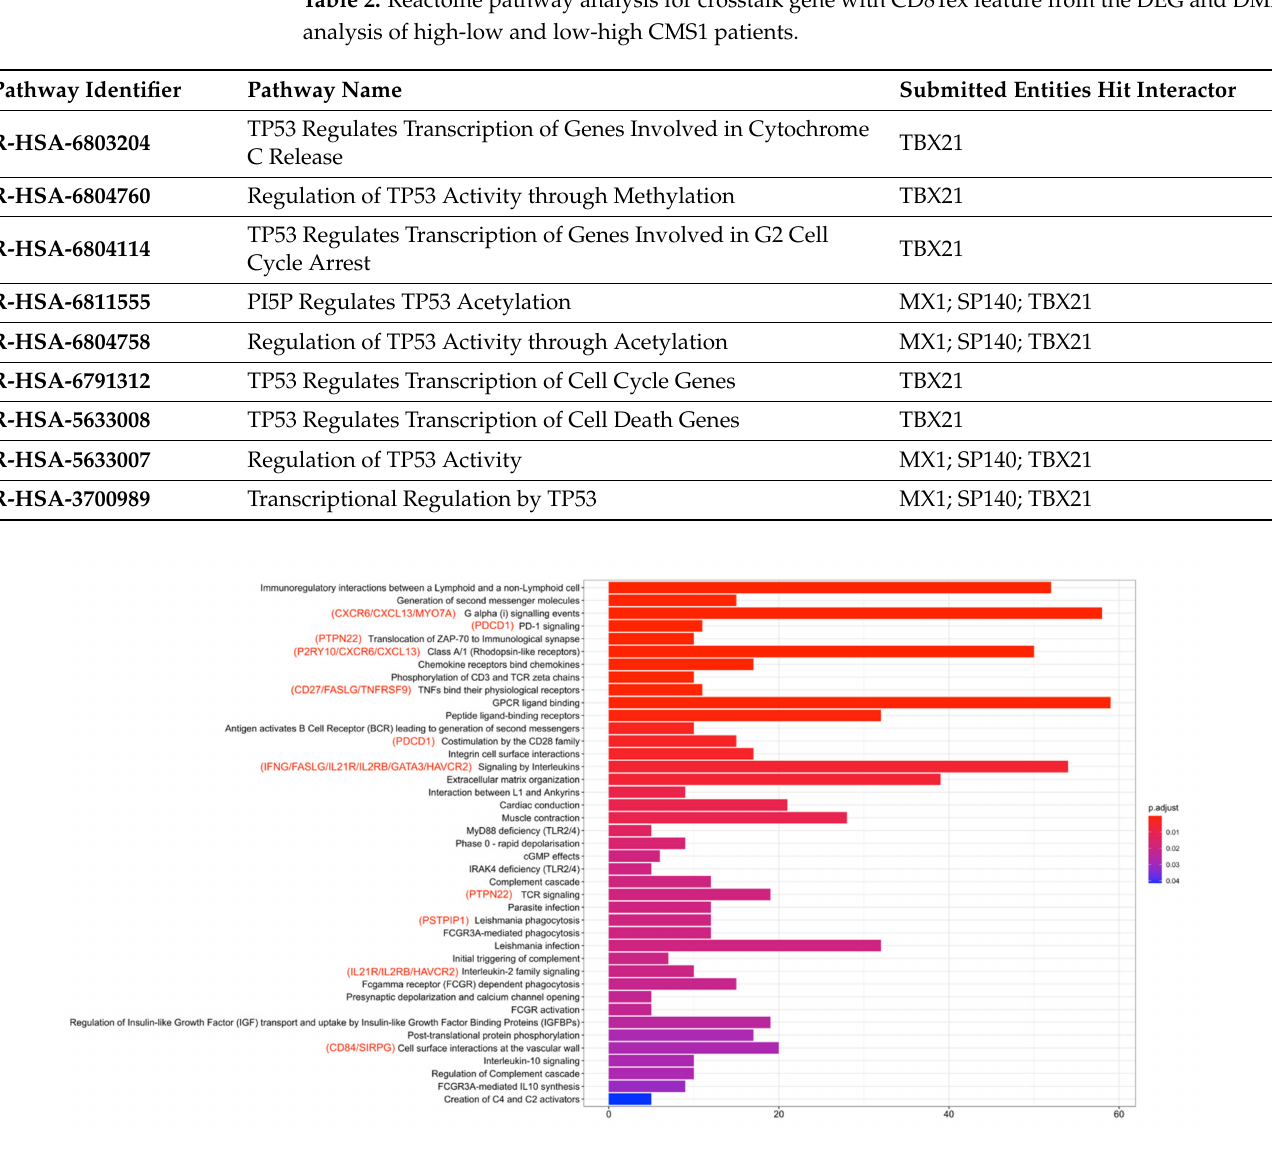
Figure 8. Eighteen CD8+ T EX marker genes were enriched in thirteen pathways, all of which were upregulated in high-low patients. Longer bars indicate that more DEGs were enriched in the pathway. Bar color from blue to red indicates that the DEG-enriched pathways had higher p -adjusted